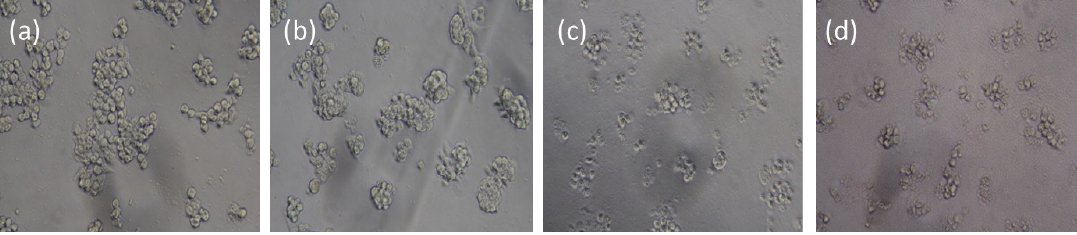
Figure 7. Bright field images of HT-29 cells without or with treatment of HRP-loaded IBN-4 nanoparticles and IAA: ( a ) Control (cells without treatment), ( b ) treatment with IAA (500 μM) , ( c ) treatment with IAA (500 μM ) and IBN-4-HRP (one- pot) (100 μg/mL) and ( d ) treatment with IAA (500 μM) and IBN -4- HRP (100